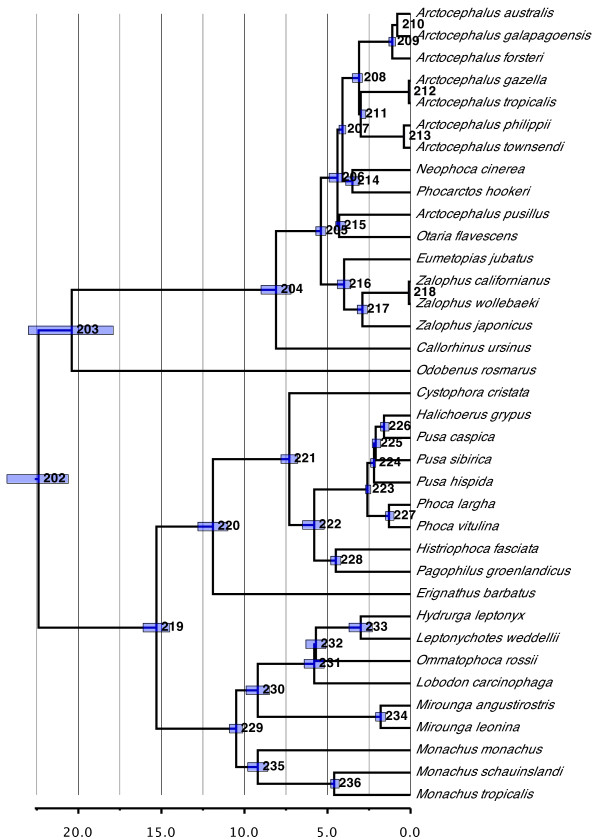
Phylogenetic relationships and divergence times estimates within Pinnipedia (Odobenidae, Otariidae, and Phocidae). Nodes are individually numbered, with node bars indicating 95% confidence intervals on the divergence time estimates (in Ma before present).